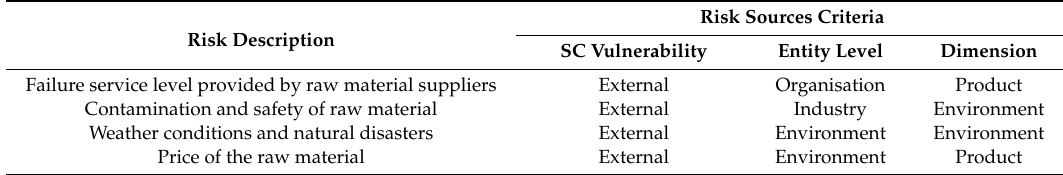
Table 2. Risks associated with the definition of the object, environment, and objectives. The table shows the risk source for each criterion indicated in the columns, for each risk described in the